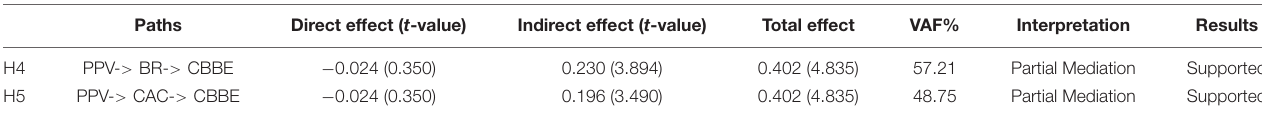
TABLE 6 | Hypotheses testing